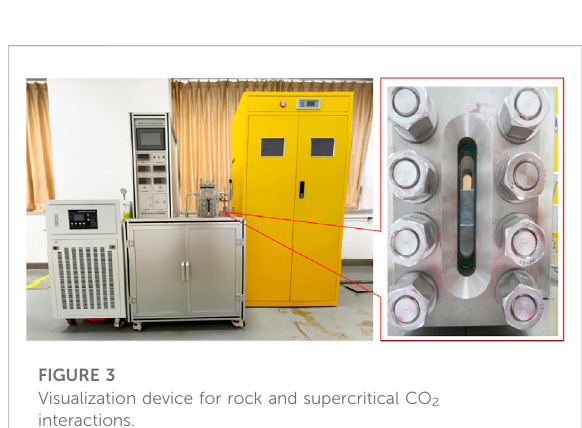
FIGURE 3 Visualization device for rock and supercritical CO 2